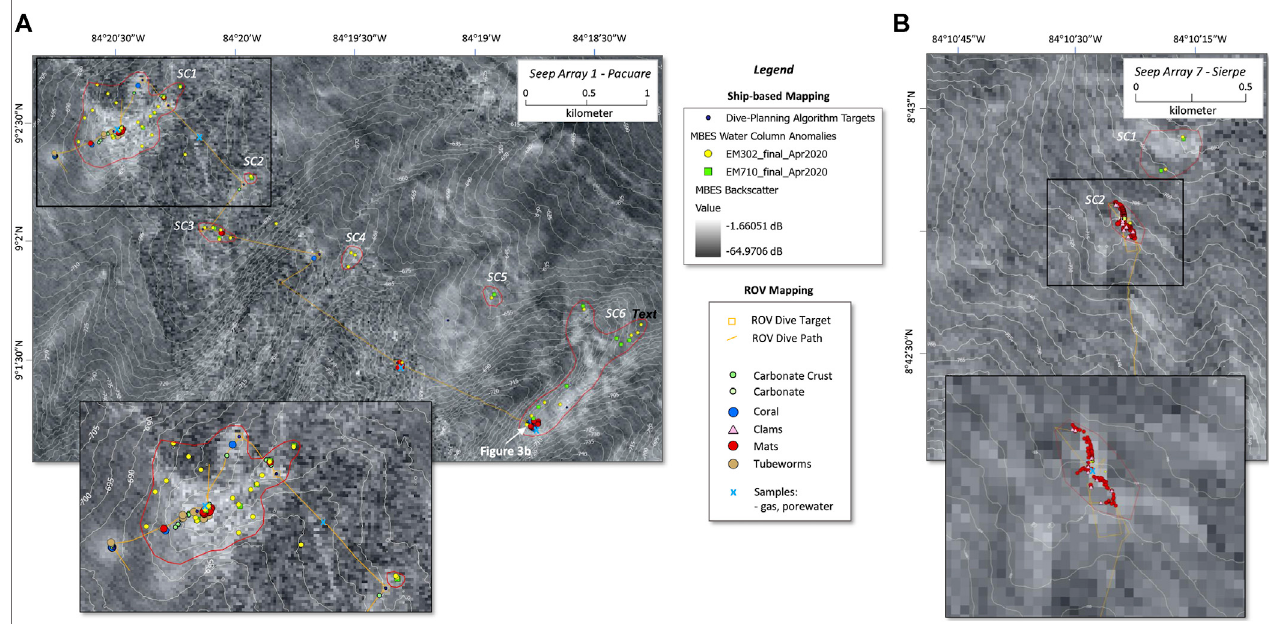
FIGURE 6 | ROV mapping of representative seep clusters. Maps illustrate MBES backscatter and bathymetric contours (meters) for two sites with different seep characteristics. Seep clusters de fi ned from ship-based mapping are de fi ned by red polygon outlines, labeled by Seep Cluster number. ROV observations annotated in Squidle + are superimposed. (A) Seep Array 1 — Pacuare contains six clusters between 600 and 650 m water depth. Four clusters (SC1-3, SC6) were occupied during ROV dives SO205/SO206, and display heterogeneous distribution of carbonate crusts, corals, bacterial mats, and tubeworms that occur in regions of higher backscatter. SC1 characterized by mound-shaped geometry (inset map) while remaining clusters occur on topographic ridges, fl ats, and valleys. (B) Seep Array 7 — Sierpe contains only two seep clusters between 690 and 720 m water depth, dominated by bacterial mats, with no carbonate crusts. Sea fl oor topography fl at with backscatter values close to background (inset